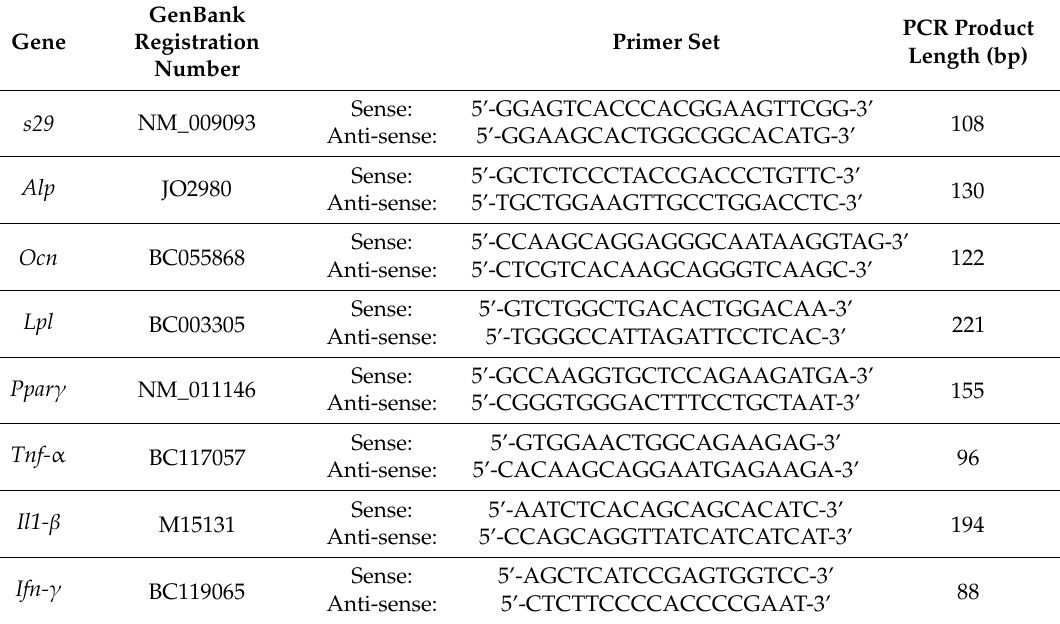
Table 1. Nucleotide sequence of the primers used for real-time